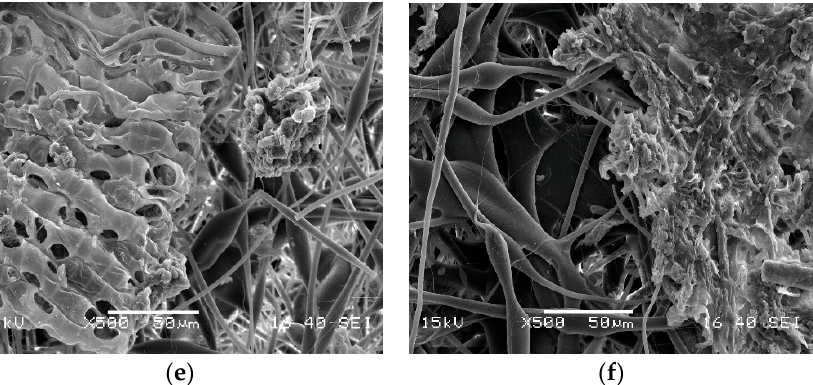
Figure 2. Scanning electron micrographs (a lateral view) after 220 days of soil exposure of PLA/NR samples with different NR content, wt.%: 0 ( a ), 5 ( b ), 10 ( c , e ), 15 ( d , f ). Micrographs ( e , f ): a surface view.